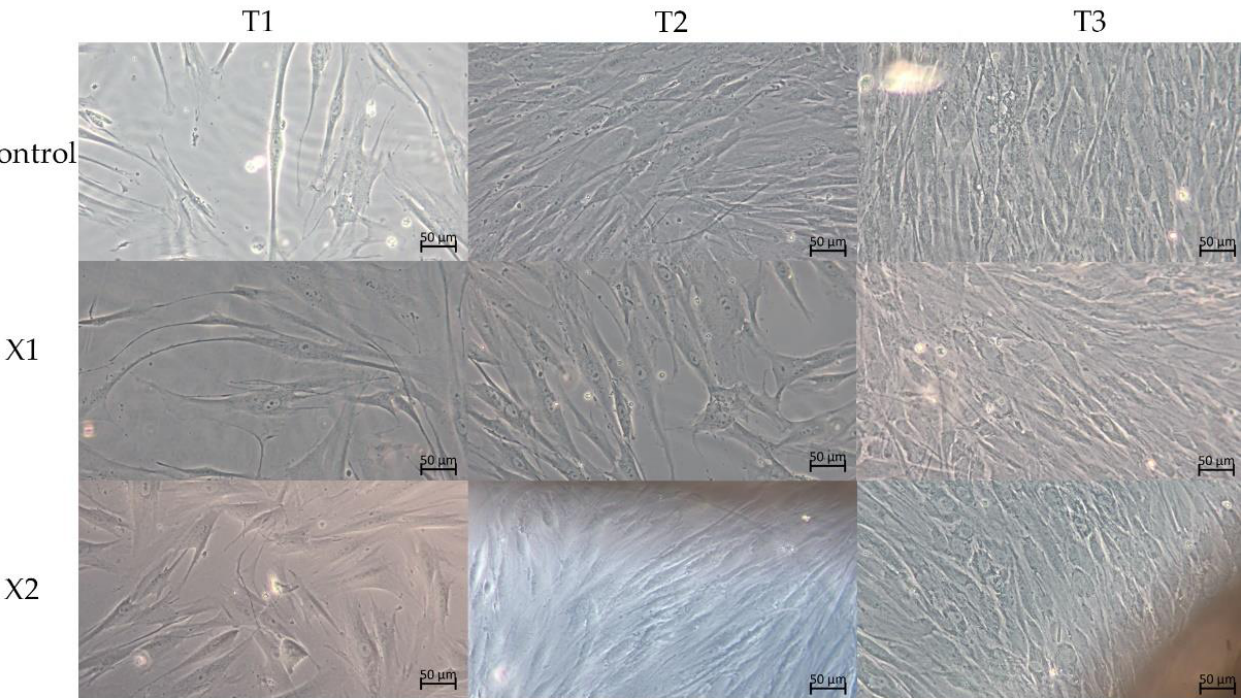
Table 1. Bonferroni’s post hoc multiple comparison results. N.S. = not significant.